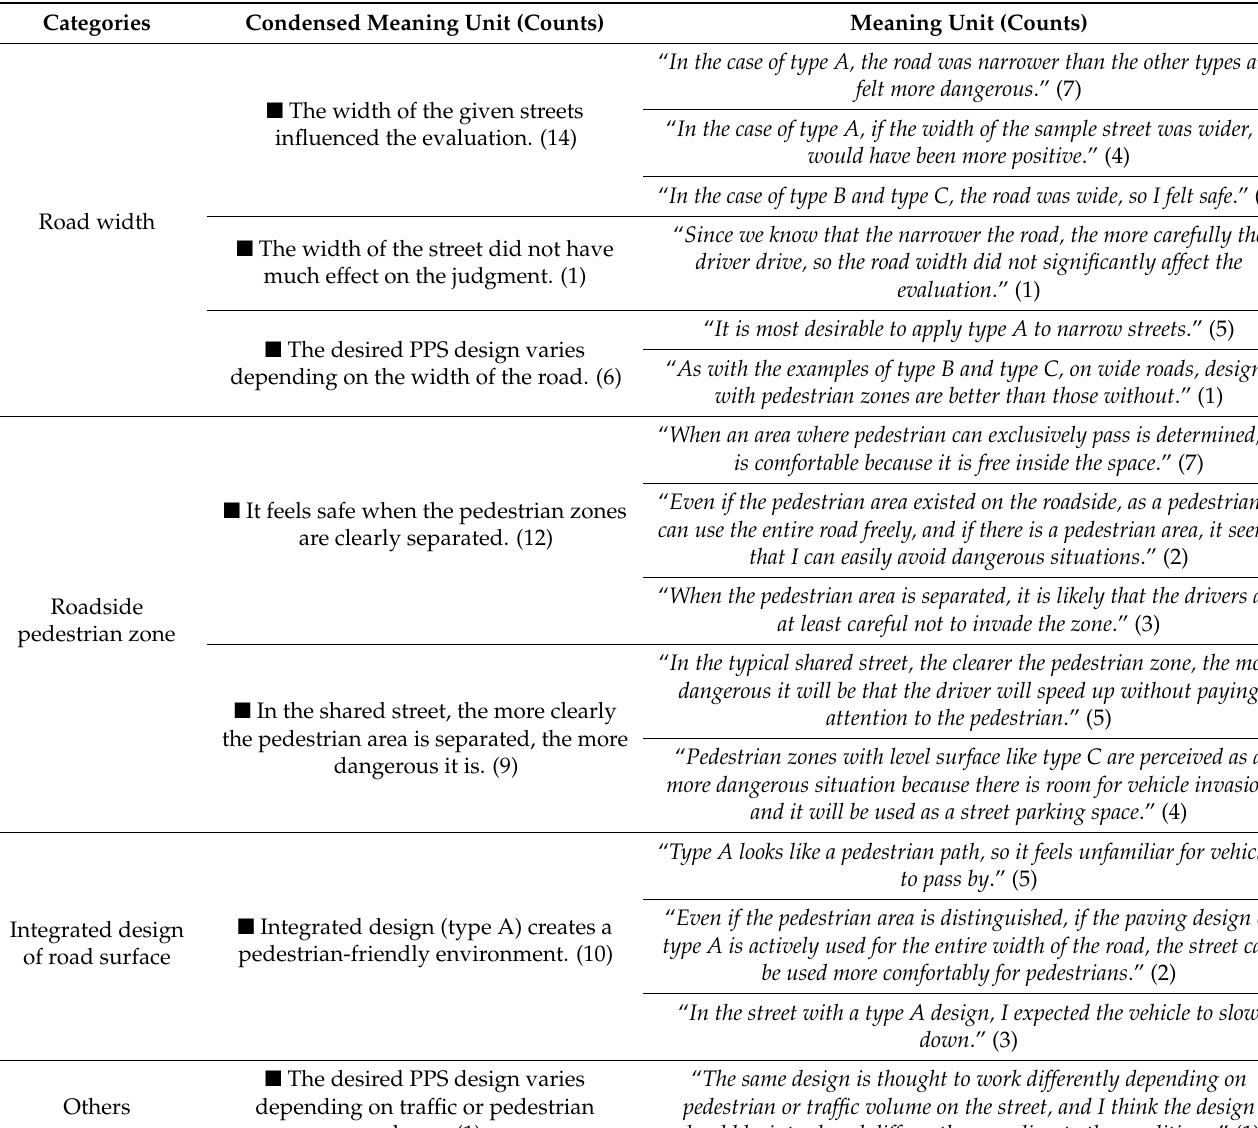
Table 6. Results of interview content